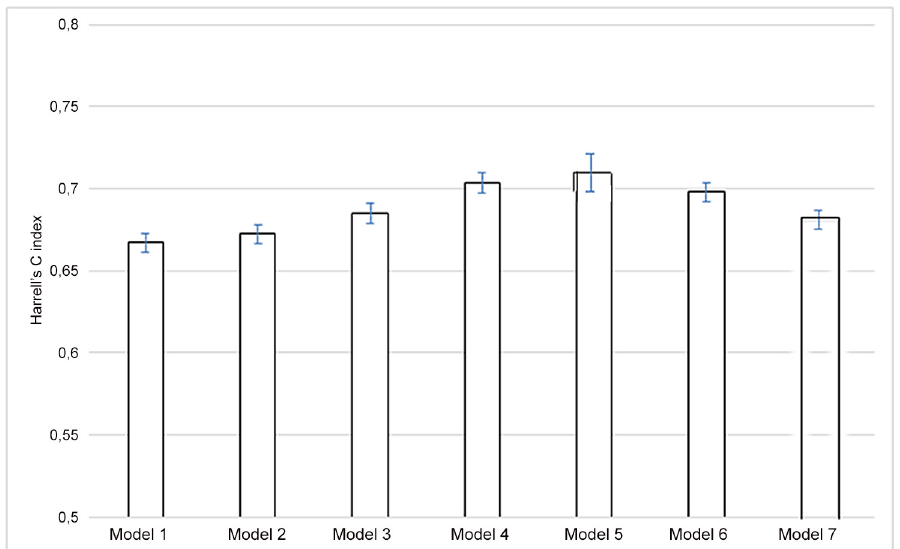
Fig 3. Harrell ’ s C-index for the various Cox models. Model 1, traditional risk factors (TRFs): 0.67 ± 0.35; Model 2, TRFs + PWV: 0.67 ± 0.036; Model 3, TRFs + IMT: 0.69 ± 0.036; Model 4, TRFs + aortic calcification score (CT scan): 0.70 ± 0.036; Model 5, TRFs + aortic calcification score (X-ray): 0.71 ± 0.05; Model 6, TRFs + coronary artery calcification score: 0.70 ± 0.036; Model 7, TRFs + ABI ( < 1.3 vs. > 1.3) 0.69 ± 0.035. All differences were